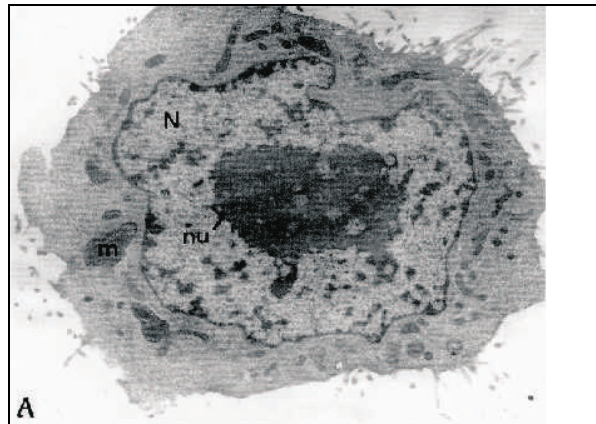
FIGURA 3b - Elétron-micrografia de células tumorais de Ehrlich do grupo-controle. Detalhe da célula tumoral: Citoplasma com pequenas mitocôndrias (m), complexo de Golgi ( l ), cisterna de retículo endoplasmático rugoso (rer), vacúolos (V), núcleo (N) e projeções de superfície (p).X